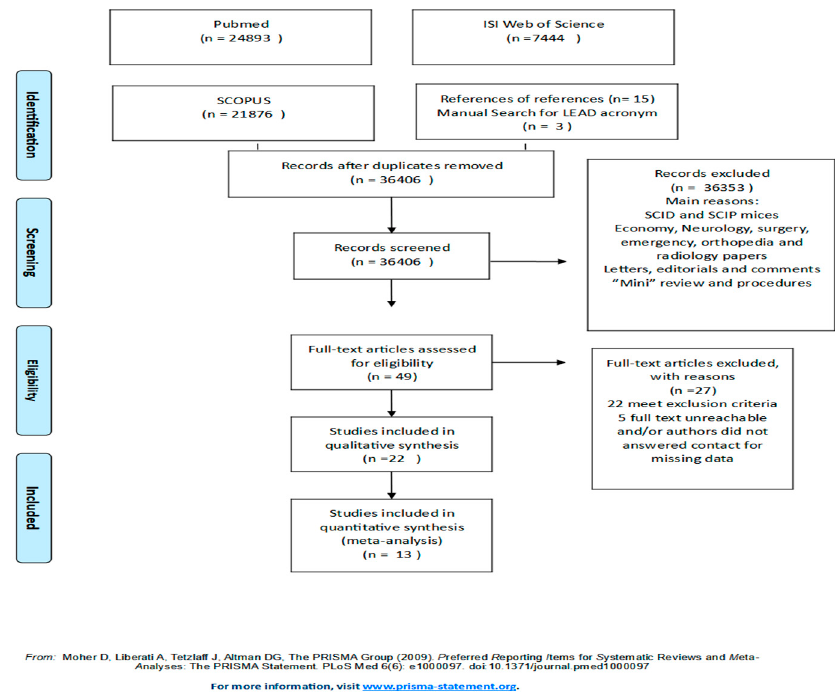
Figure 1. Screening, selection, inclusion and exclusion workflow.